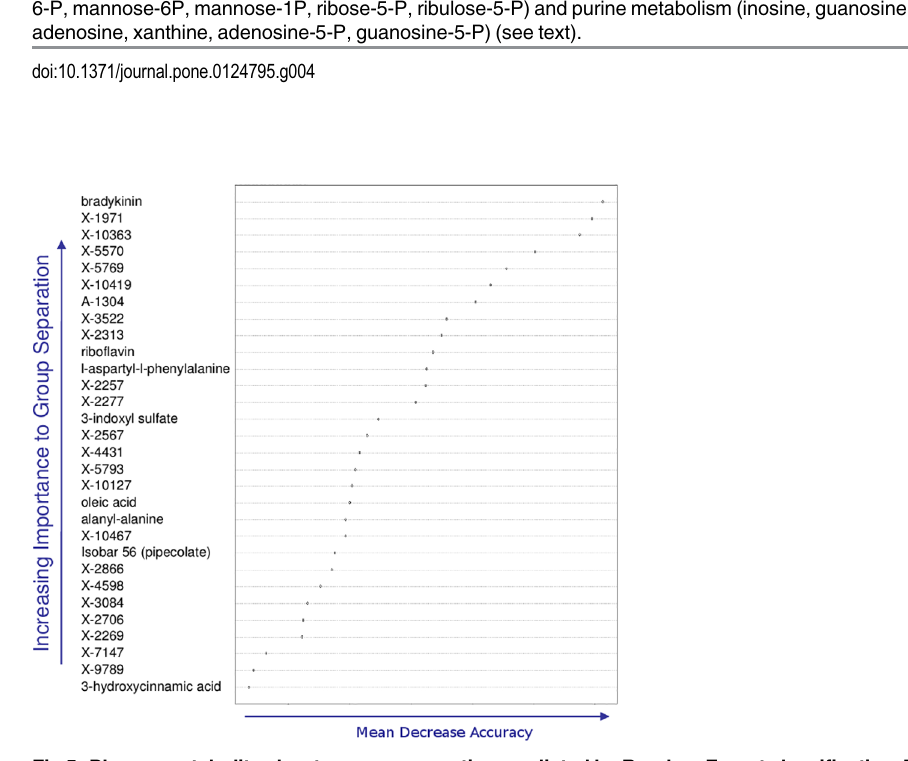
Fig 5. Plasma metabolites key to group separation predicted by Random Forest classification. The top 30 plasma metabolites important for increasing class separation as determined by the Random Forest approach. Bradykinin was seen as most important for class separation, however, smaller peptides also showed class discrimination, such as L-aspartyl-L-phenylalanine, and alanyl-alanine. Energy metabolism, as reflected by the presence of riboflavin as a biomarker, was indicated. Metabolites suggesting multiple organ interactions, i.e. kidney/liver/GI tract/microbiome were indicated (see text).